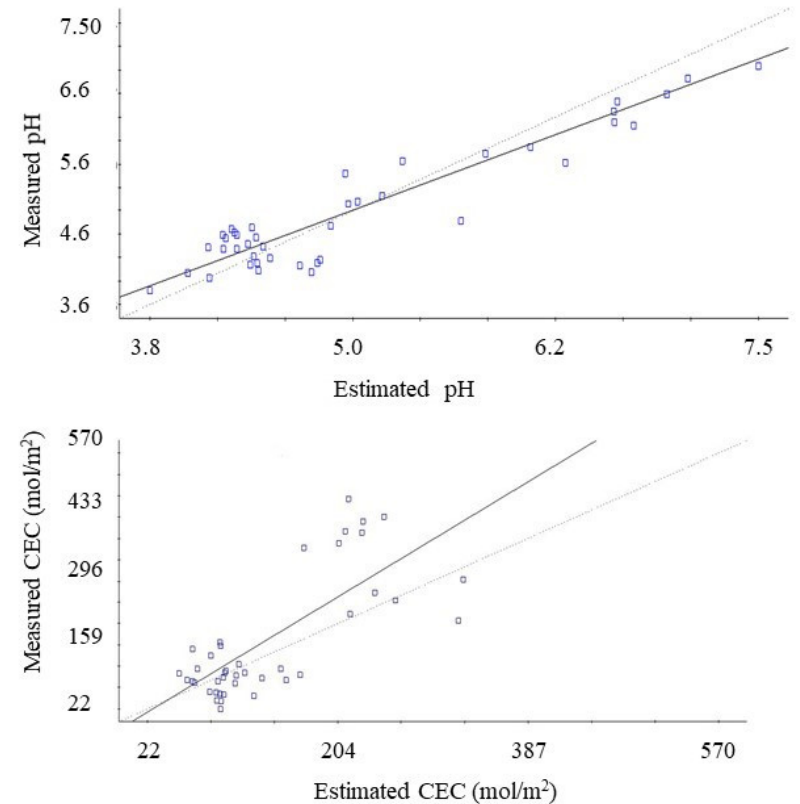
Figure 4. Cross-validation graphs of selected soil properties (pH and CEC). Figure 4. Cross ‐ validation graphs of selected soil properties (pH and CEC).